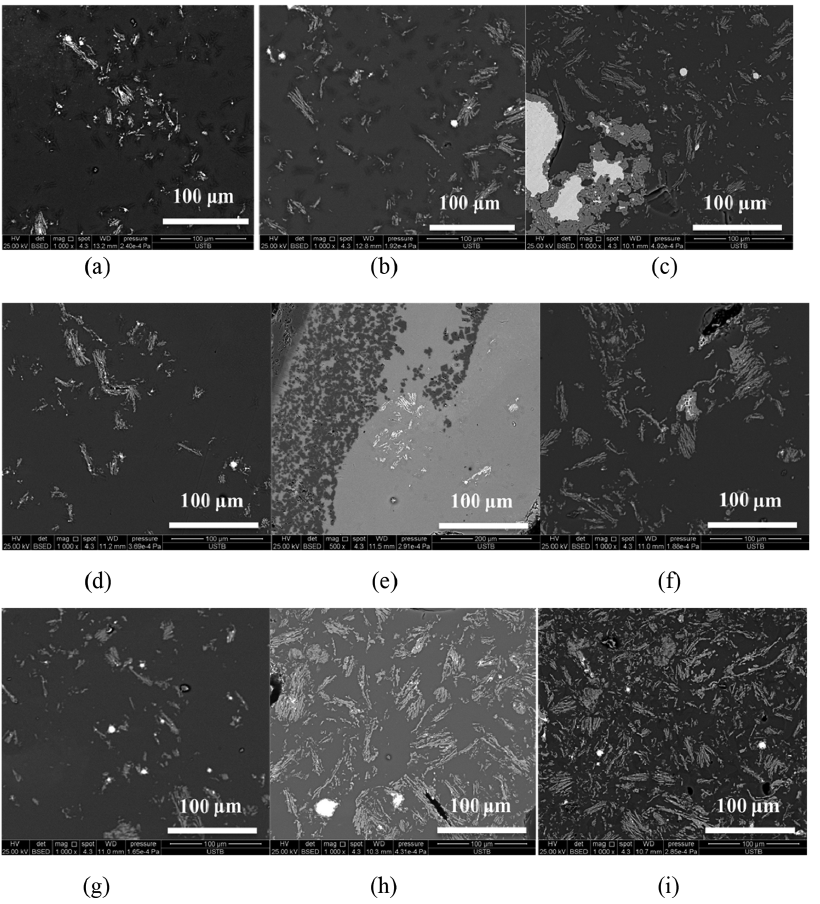
Figure 16: BSED images of the samples reduced with different carbon ratios for different times at 1,673 K: (a) 2 h, 0.7; (b) 2 h, 0.85; (c) 2 h, 1.0; (d) 4 h, 0.7; (e) 4 h, 0.85; (f) 4 h, 1.0; (g) 6 h, 0.7; (h) 6 h, 0.85 and (i) 6 h,